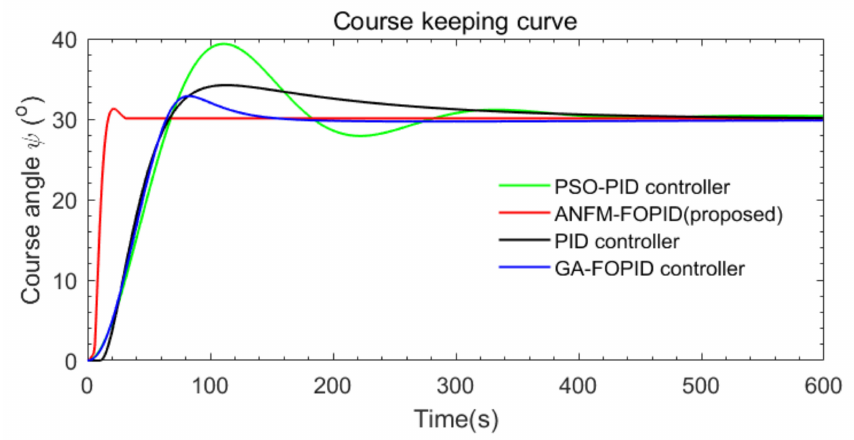
Figure 22. Comparison of course keeping using four different controllers.